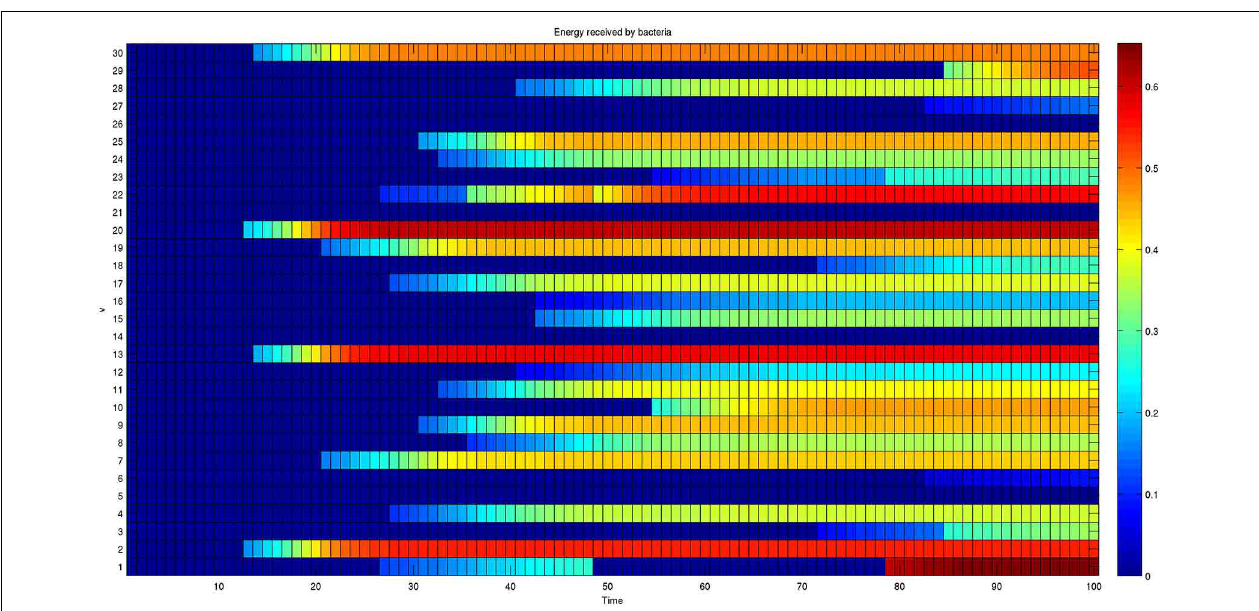
FIGURE 6 | Dynamics of the energy received by each member of a network composed of 30 bacteria. The colors reported in each row represent the energy received by a single bacterium over time. The energy